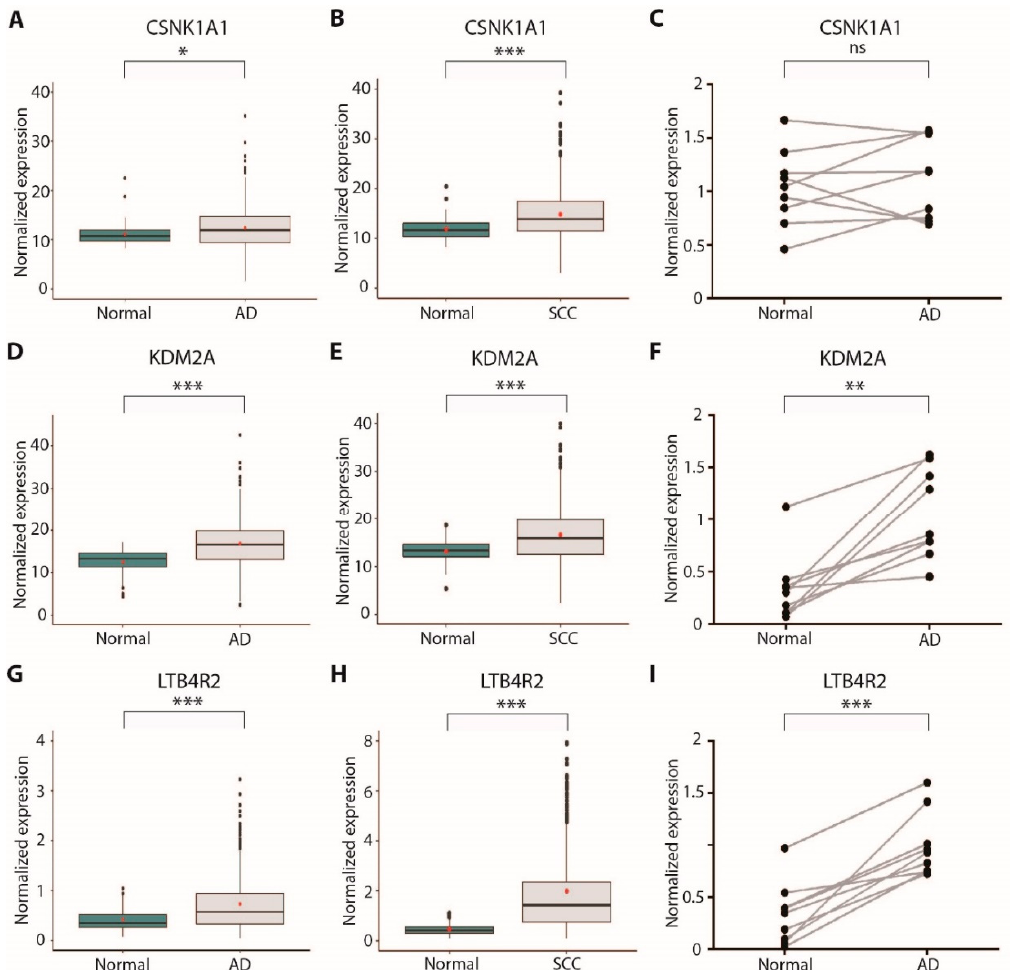
Figure 5. Expression analysis of new druggable dependency genes in lung cancer patients: ( A ) CSNK1A1 expression in TCGA lung adenocarcinoma cohort samples (n = 572, normal = 59, tumor = 513), measured by RNA-Seq; ( B ) CSNK1A1 expression in TCGA lung squamous-cell carcinoma cohort samples (n = 550, normal = 49, tumor = 501), measured by RNA-Seq; ( C ) CSNK1A1 expression in a set of surgical samples from our institute’s biobank (n = 9), measured by RT-qPCR; ( D ) KDM2A expression in TCGA lung adenocarcinoma cohort samples (n = 572, normal = 59, tumor = 513), measured by RNA-Seq; ( E ) KDM2A expression in TCGA lung squamous-cell carcinoma cohort samples (n = 550, normal = 49, tumor = 501), measured by RNA-Seq; ( F ) KDM2A expression in a set of surgical samples from our institute’s biobank (n = 9), measured by RT-qPCR; ( G ) LTB4R2 expression in TCGA lung adenocarcinoma cohort samples (n = 572, normal = 59, tumor = 513), measured by RNA-Seq; ( H ) LTB4R2 expression in TCGA lung squamous-cell carcinoma cohort samples (n = 550, normal = 49, tumor = 501), measured by RNA-Seq; ( I ) LTB4R2 expression in a set of surgical samples from our institute’s biobank (n = 9), measured by RT-qPCR; * p < 0.05; ** p < 0.01; *** p < 0.001; ns = not significant.